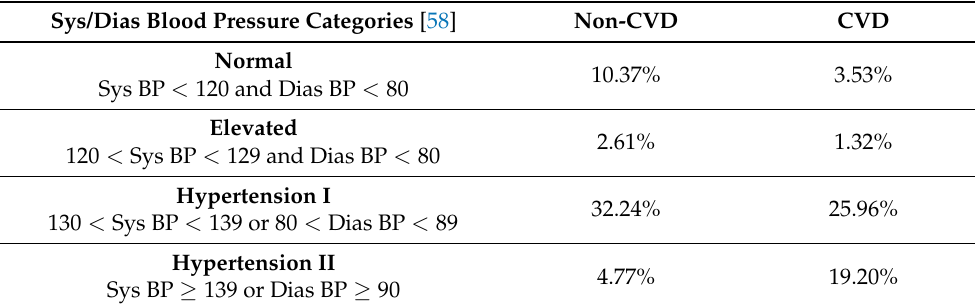
Table 8. Participants’ distribution in terms of blood pressure category in the balanced dataset.